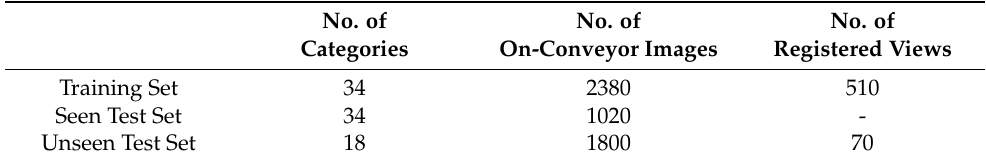
Table 2. Distribution of the fine-grained recognition dataset.